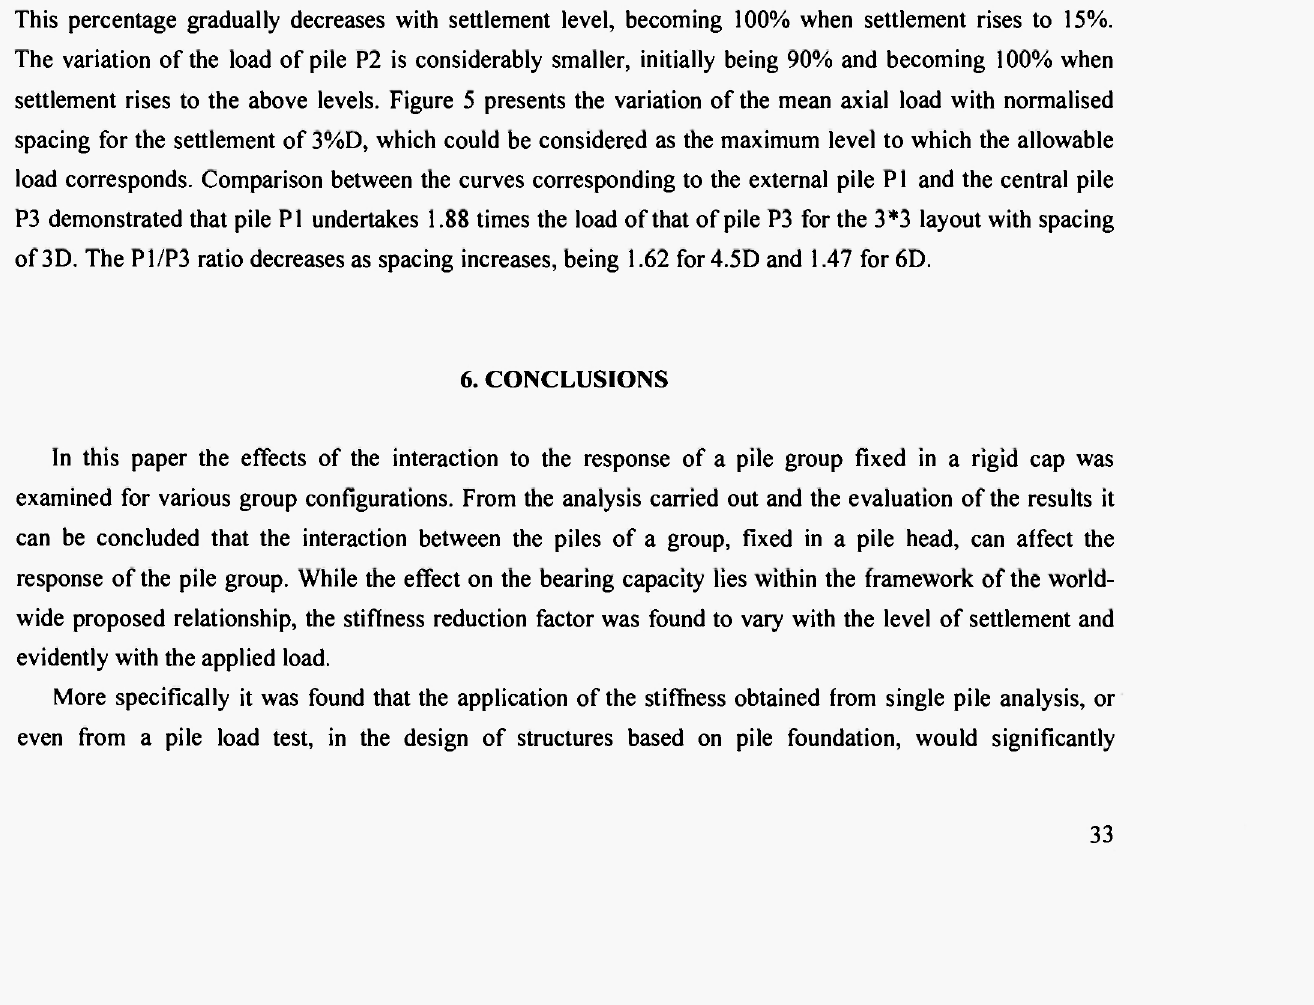
Fig. 5: Variation of normalised load with normalised settlement for piles PI, P2 and P3 in a 3*3 layout with normalised